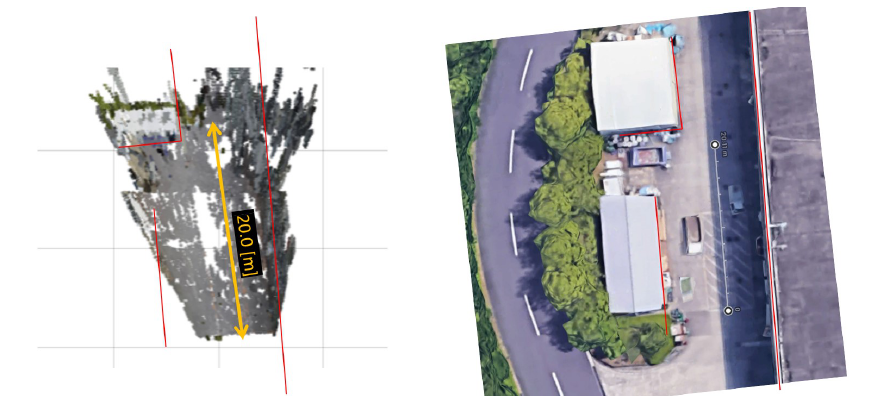
Figure 22. Shape and scale comparison of the resultant point cloud to ground truth obtained from Google